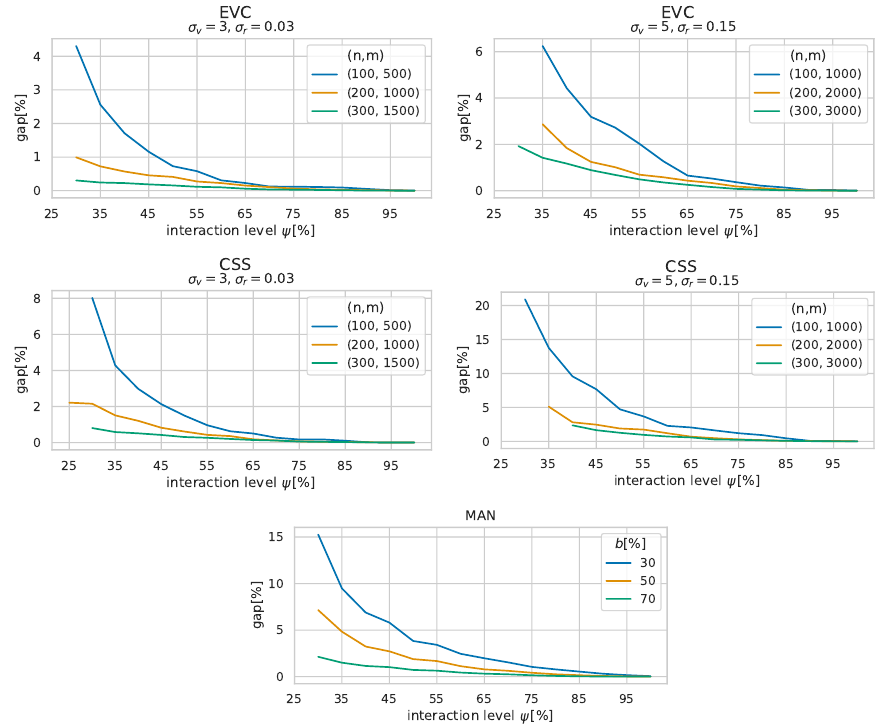
Figure 5. Development of average optimality gaps with an increasing number of user interactions for each benchmark instance